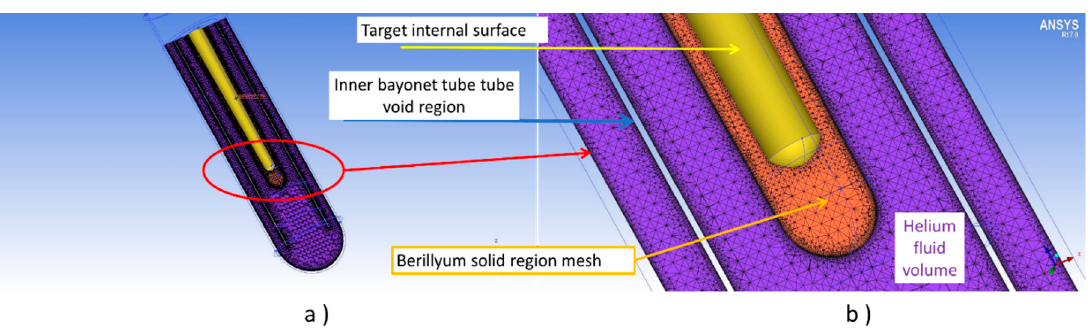
Figure 3. Computational domain with indications of the zones and an axial view of the mesh. ( a ) Axial view of the computational domain; ( b ) Indications of the zones of the mesh.